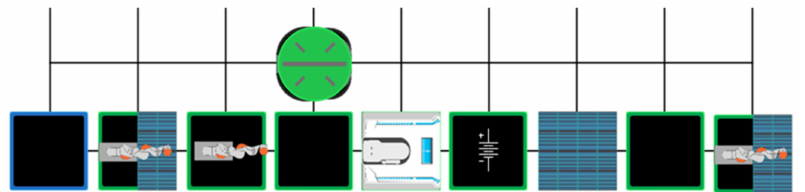
Figure 3. Modular platforms with a single row random